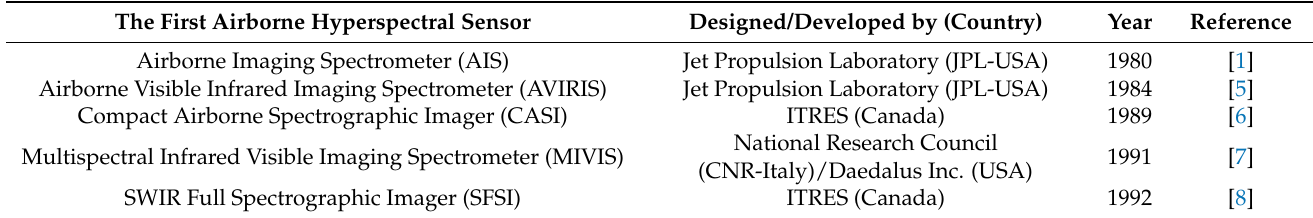
Table 1. The first airborne hyperspectral